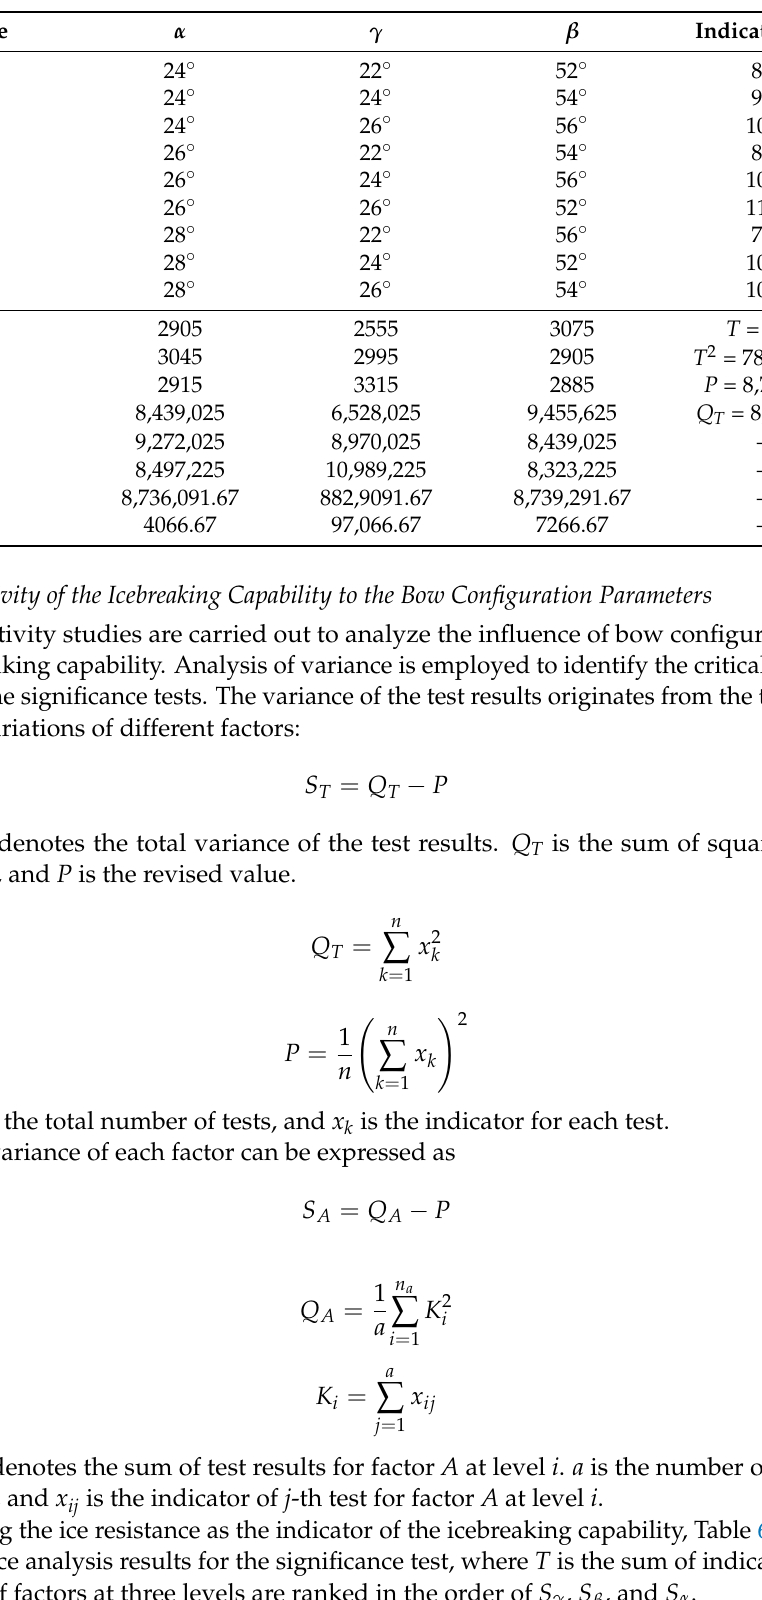
Table 6. Analysis of variance for the ice